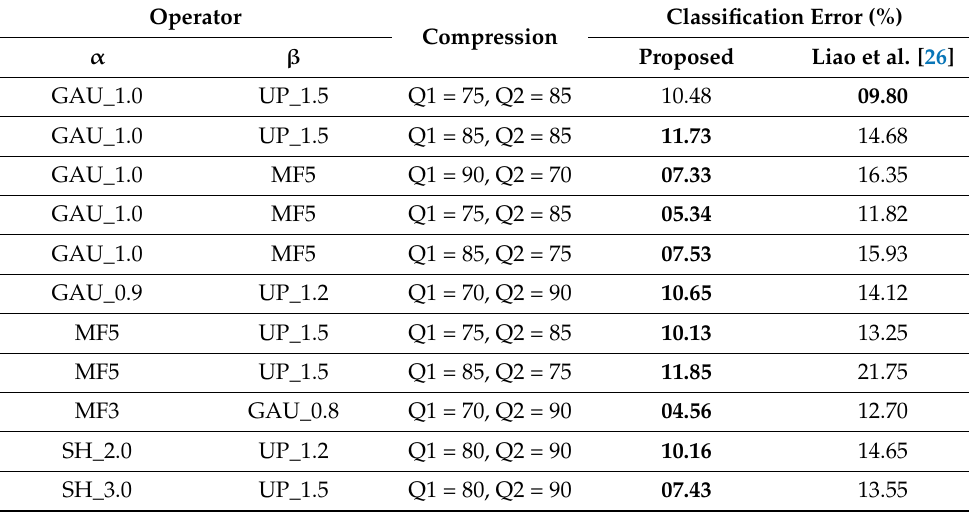
Table 7. Comparative analysis of compressed